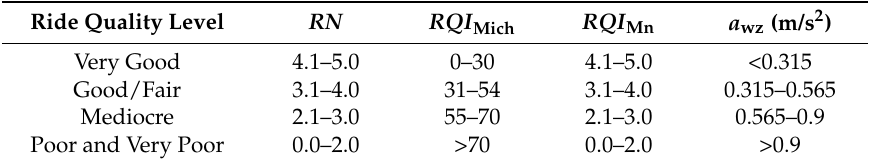
Table 4. Ride quality thresholds considered for evaluation agreement